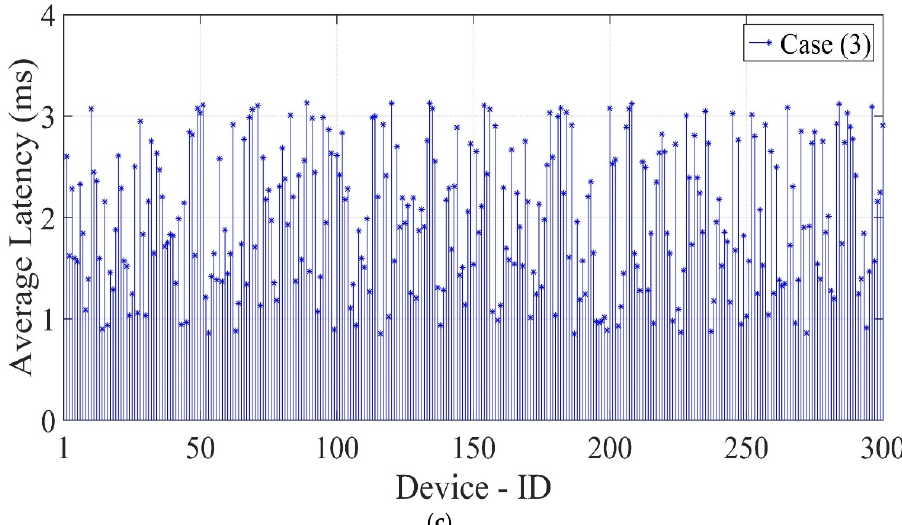
Figure 8. Average latency of handling IoT tasks for the three considered cases of the first scenario. ( a ) Average latency for case (1), ( b ) Average latency for case (2), and ( C ) Average latency for case (3).